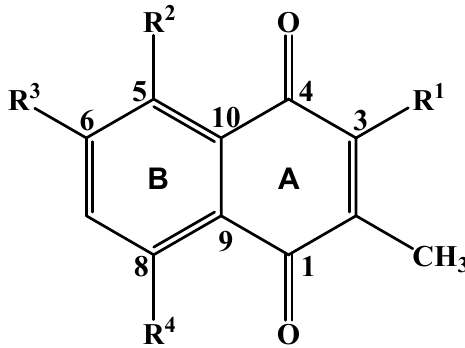
, R 3 = OH, R 4 = H; for ancistroquinone C 3